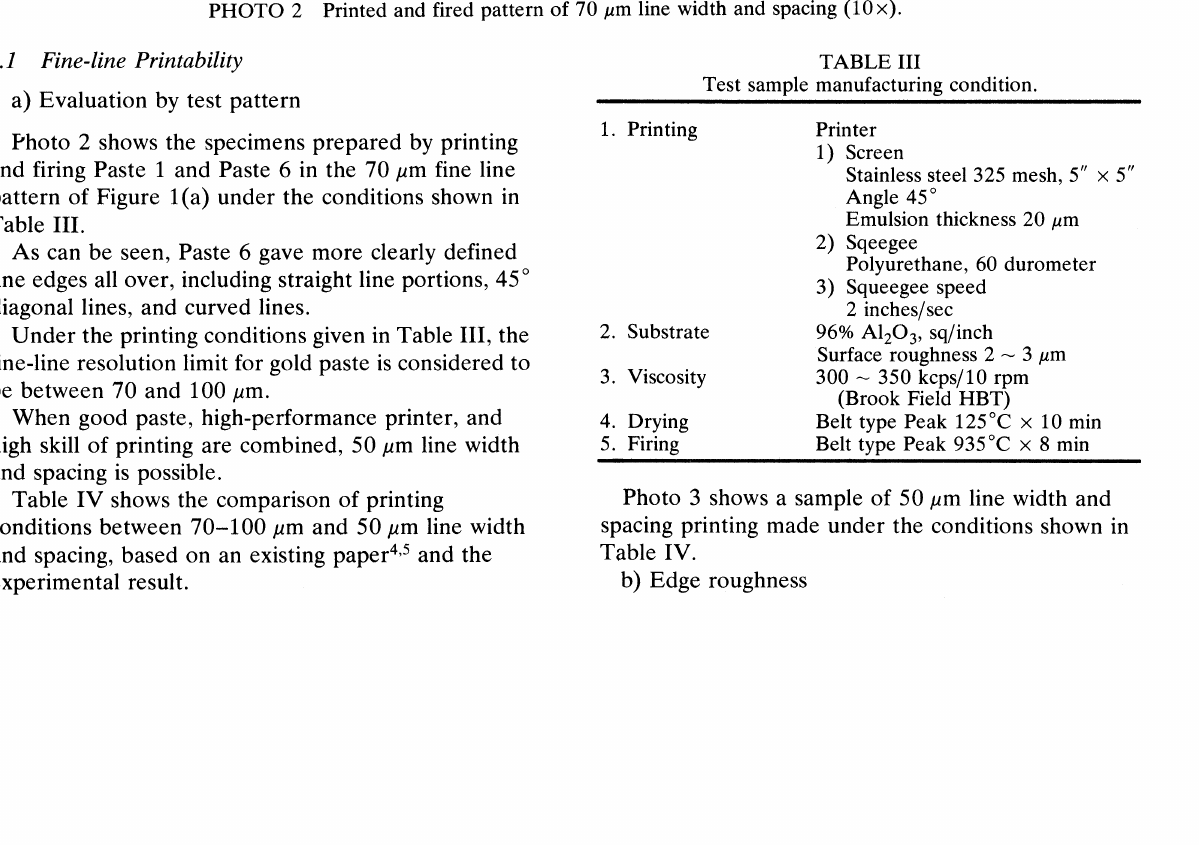
TABLE III Test sample manufacturing